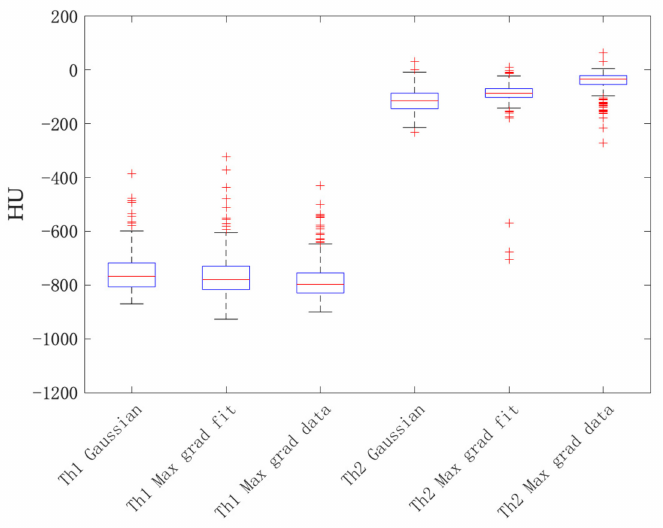
Figure 6. Boxplot of the distributions of threshold values Th1 and Th2 according to method used: Gaussian, maximum gradient on the fit (Max grad fit) and maximum gradient on the data (Max grad